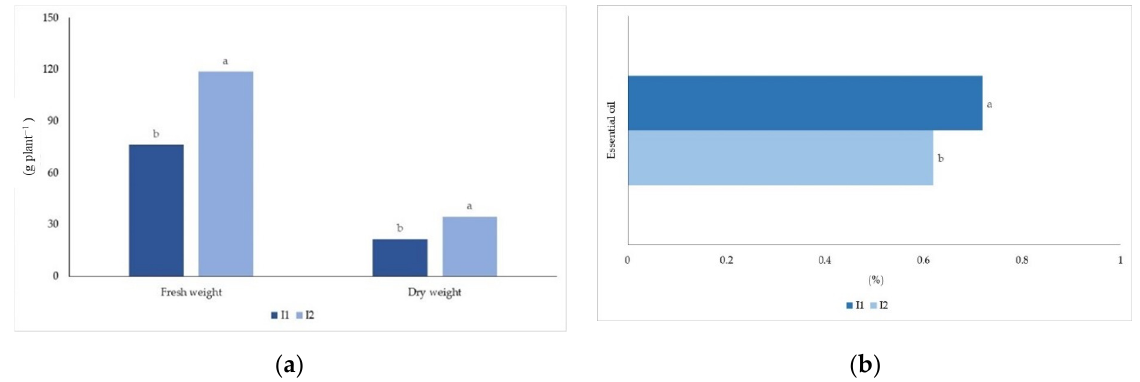
Figure 4. Effect of irrigation on production characteristics of rosemary biotypes. Graph ( a ) refers to effect of irrigation on fresh and dry weight, while graph ( b ) refers to effect of irrigation on essential oil. Means followed by the same letter are not significantly different for p ≤ 0.05 according to Tukey’s test.